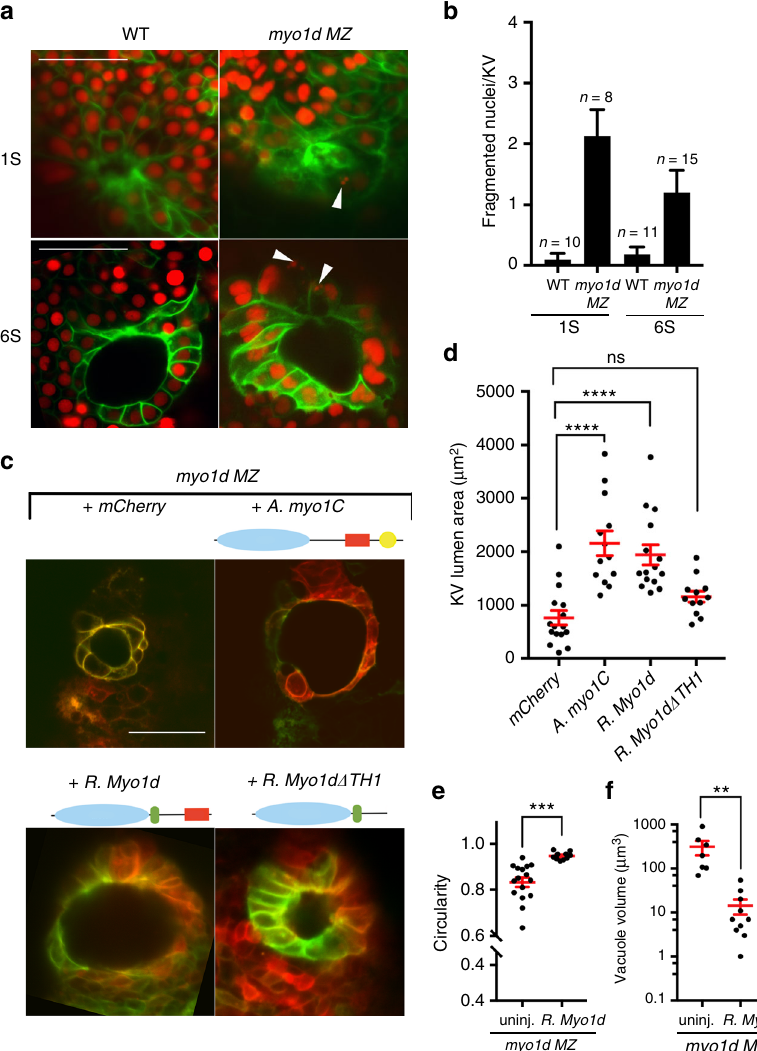
Fig. 4 Conservation of Myosin I protein function. a, b Loss of myo1d results in increased nuclear fragmentation. Tg(dusp6:GFP-MA) or myo1d MZ ; Tg(dusp6: GFP-MA) embryos injected with H2BmCherry mRNA exhibit fragmented nuclei in KV epithelial cells and quanti fi ed as fragmented nuclei per KV sample. Fragmented nuclei are represented as absolute numbers per KV Z-section. c – f Overexpression of amoeba myo1C ( n = 13) or rat Myo1d ( n = 15) were suf fi cient to rescue lumen area in myo1d MZ embryos compared to uninjected controls ( n = 16) ( d ), circularity ( n = 16 myo1d MZ , n = 10 rat Myo1d injected MZ embryos) ( e ), and reduced vacuole size ( n = 9 myo1d MZ , n = 10 rat Myo1d injected MZ embryos ) ( f ) in myo1d MZ mutants. However, rat Myo1d lacking the TH1 domain ( myo1d Δ TH1 ) ( n = 12) failed to restore lumen size ( d ). Unpaired t test or one-way ANOVA with post hoc Turkey ’ s multiple